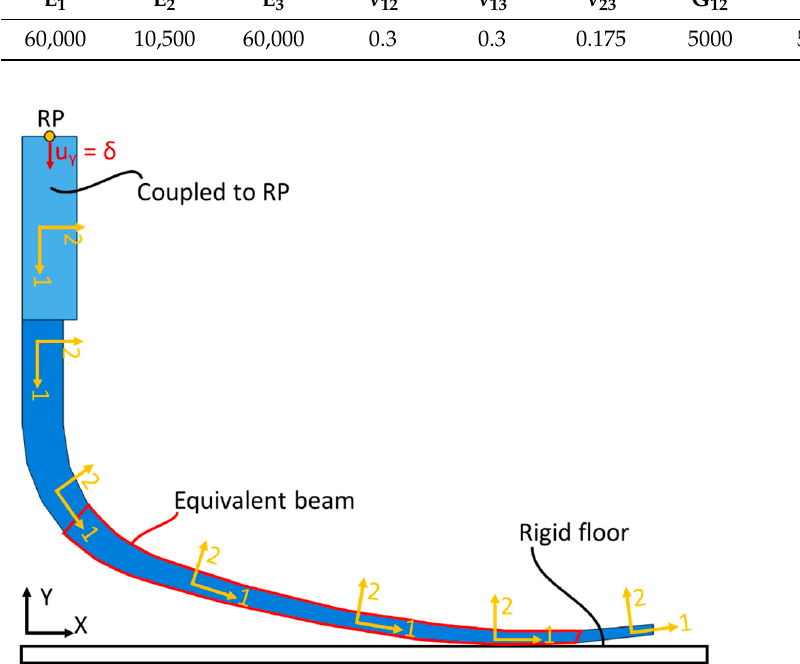
Figure 8. Model of the reference